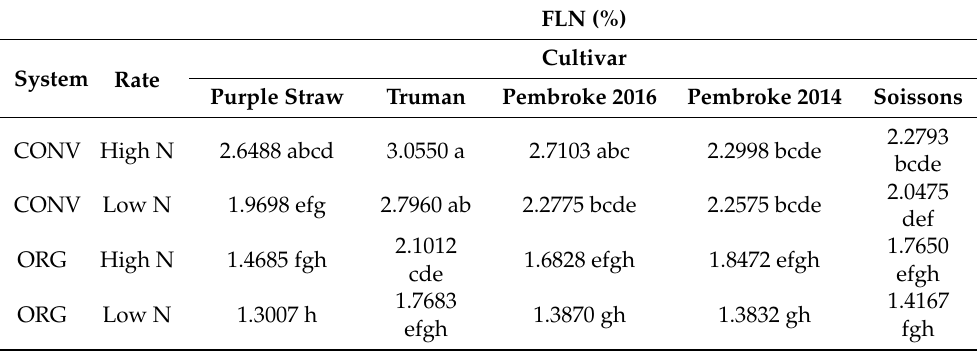
Table 5. Flag leaf nitrogen (FLN) by cultivar, as affected by system and rate at anthesis (first sampling date) in Y1 ( p = 0.038). (Same letters within each column are not significantly different based on Tukey’s honest significant difference (HSD) test performed at α = 0.05).